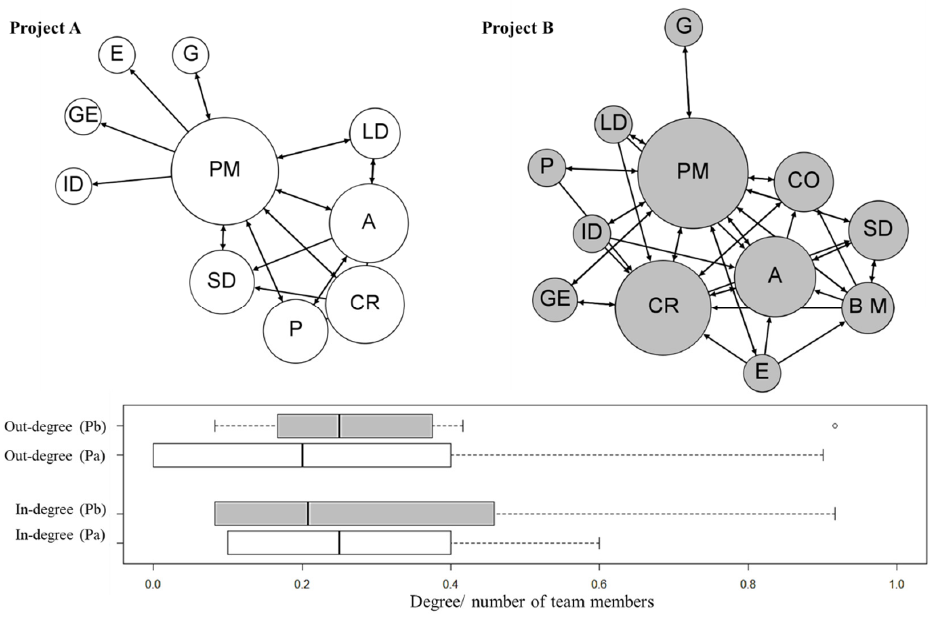
Figure 4. Relevant information flow network and degrees: Project A and project B.